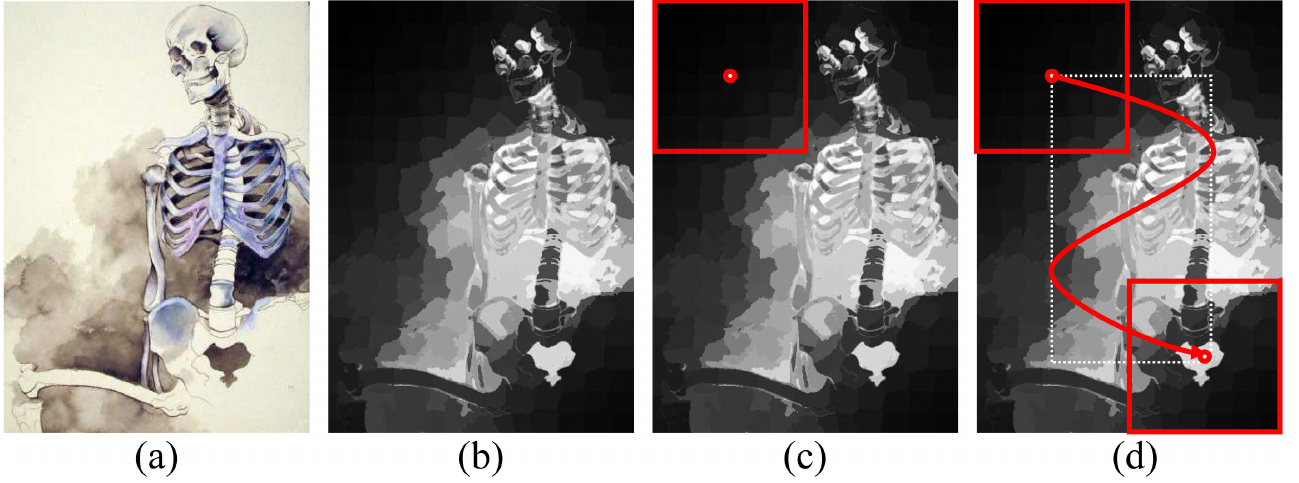
Figure 3. Process of computing the saliency score of all patches of an image. ( a ) input artwork image, ( b ) corresponding saliency map, ( c ) saliency score computation for a patch with a size of 256 × 256, ( d ) saliency score computation of all patches inside an input